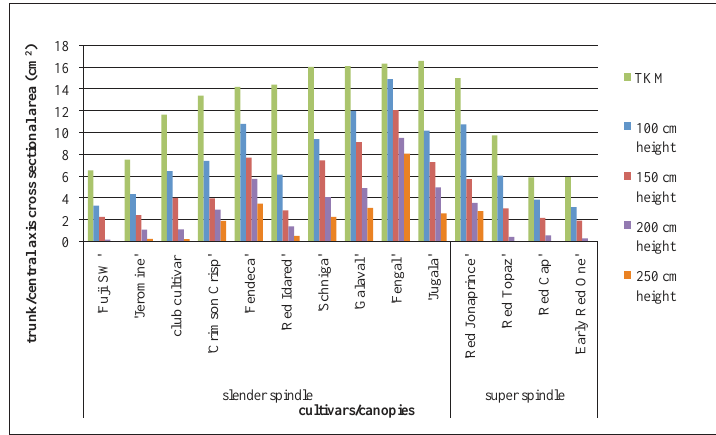
Figure 2: Thickness of the trunk and the central leader in different height zones (cm 2 ) (Nyírbátor,